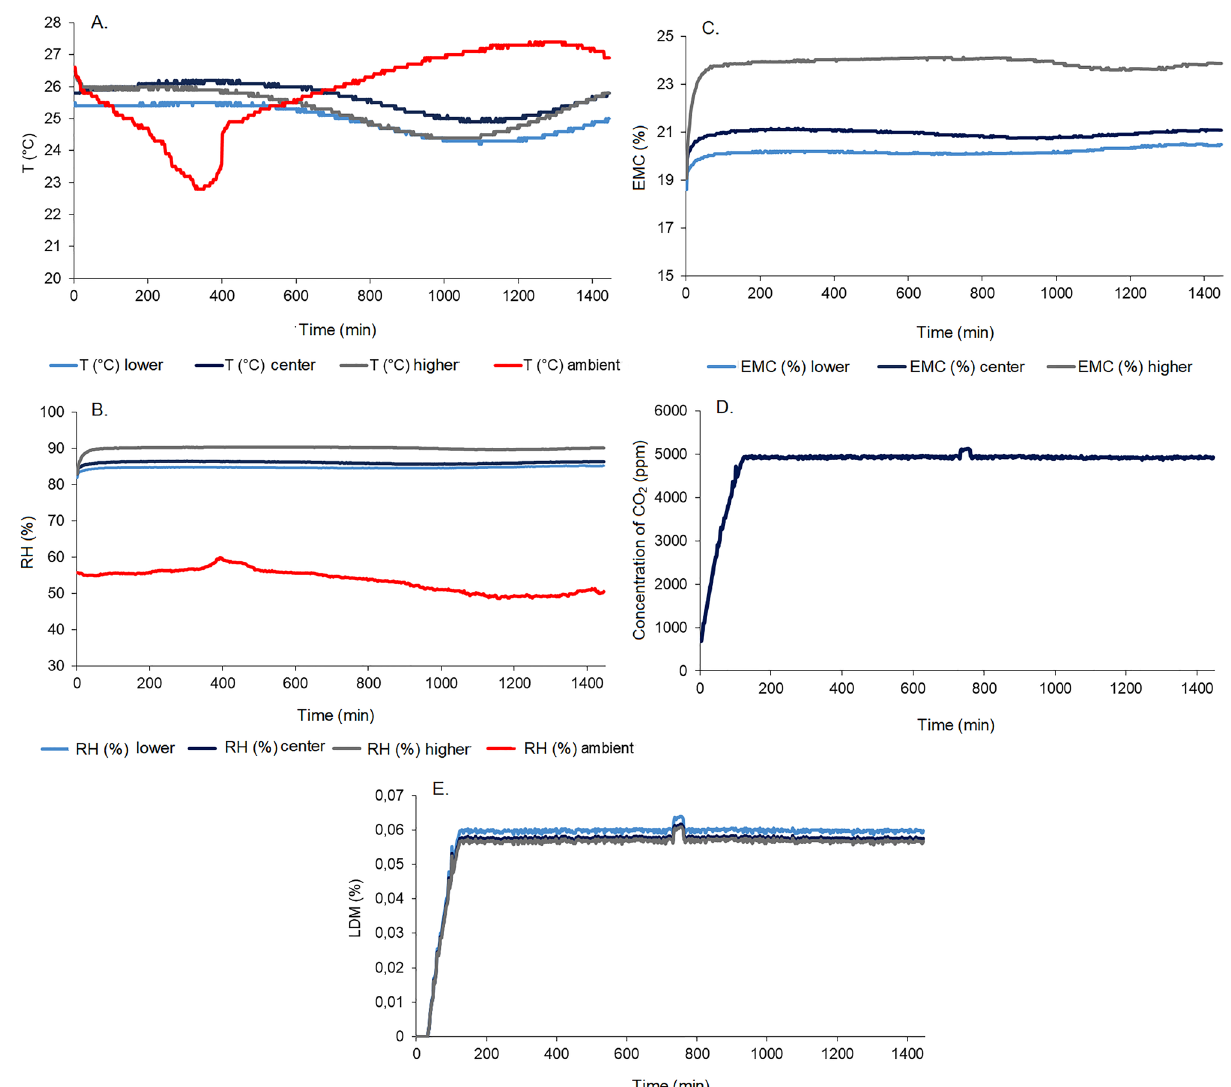
Figure 5. Monitoring temperature ( A ), relative humidity ( B ), equilibrium moisture content ( C ), carbon dioxide ( D ), loss of dry matter ( E ) of the intergranular air in the corn grain mass at 16% moisture content (w.b.) over